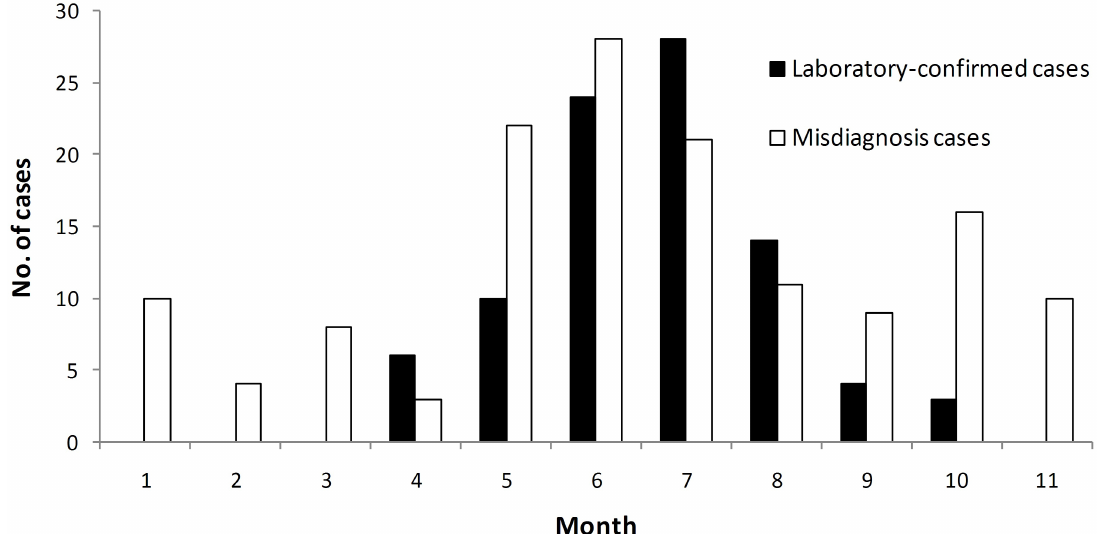
Fig 1. The temporal distribution of laboratory-confirmed cases with SFTSV infection and misdiagnosis cases in Jiangsu Province, China, 2011–2013.